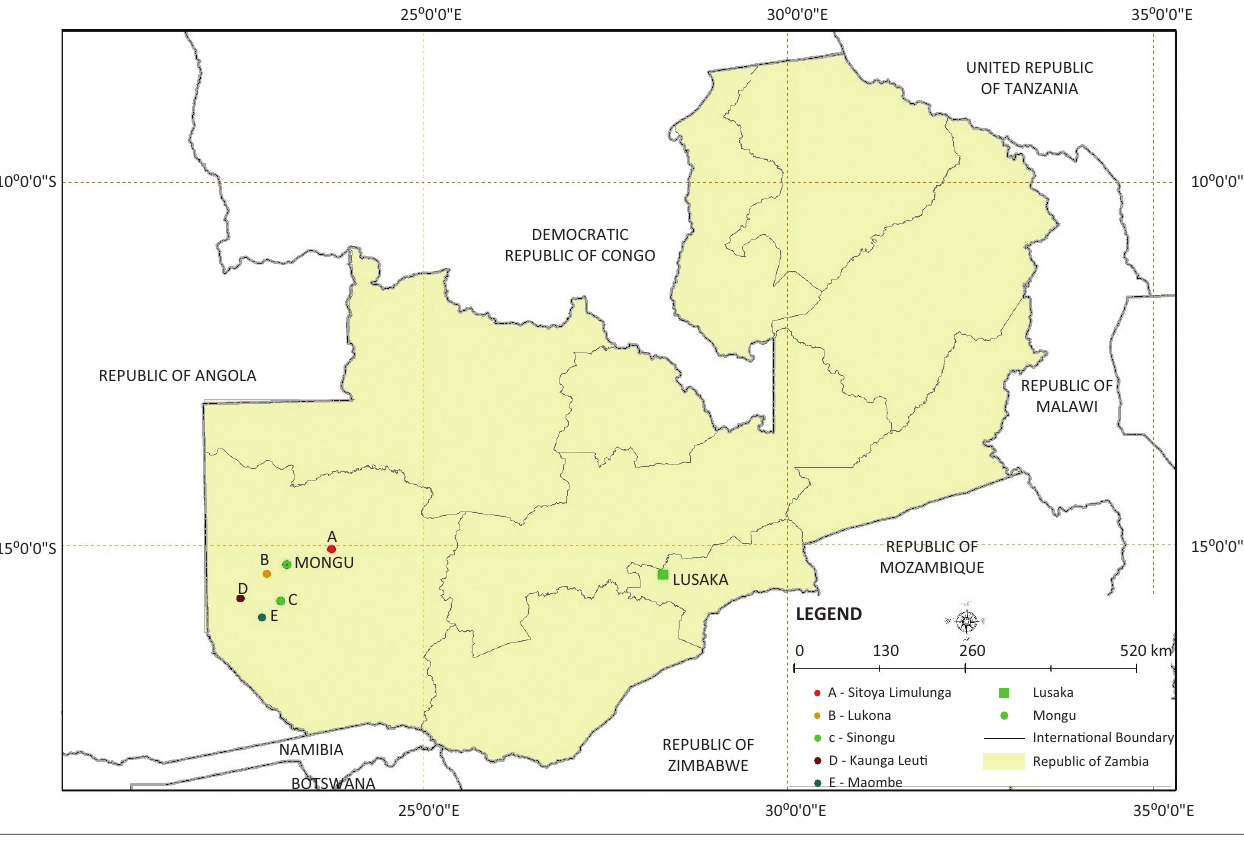
FIGURE 1: Map of Zambia showing four districts of the Western